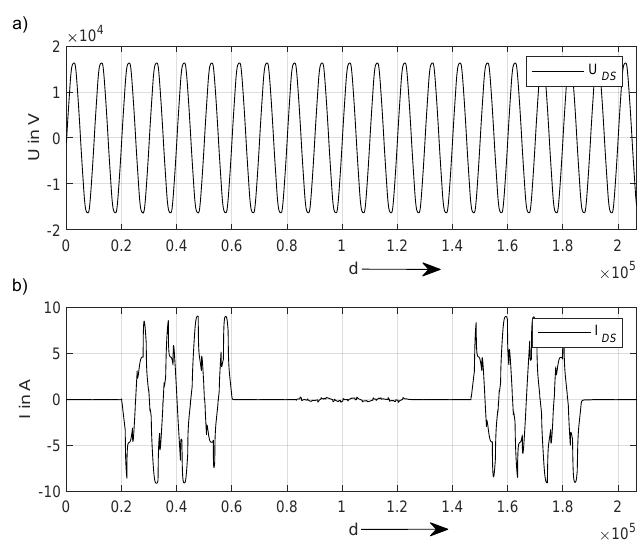
Figure 4. Measurement results with U DS ( a ) and I DS ( b